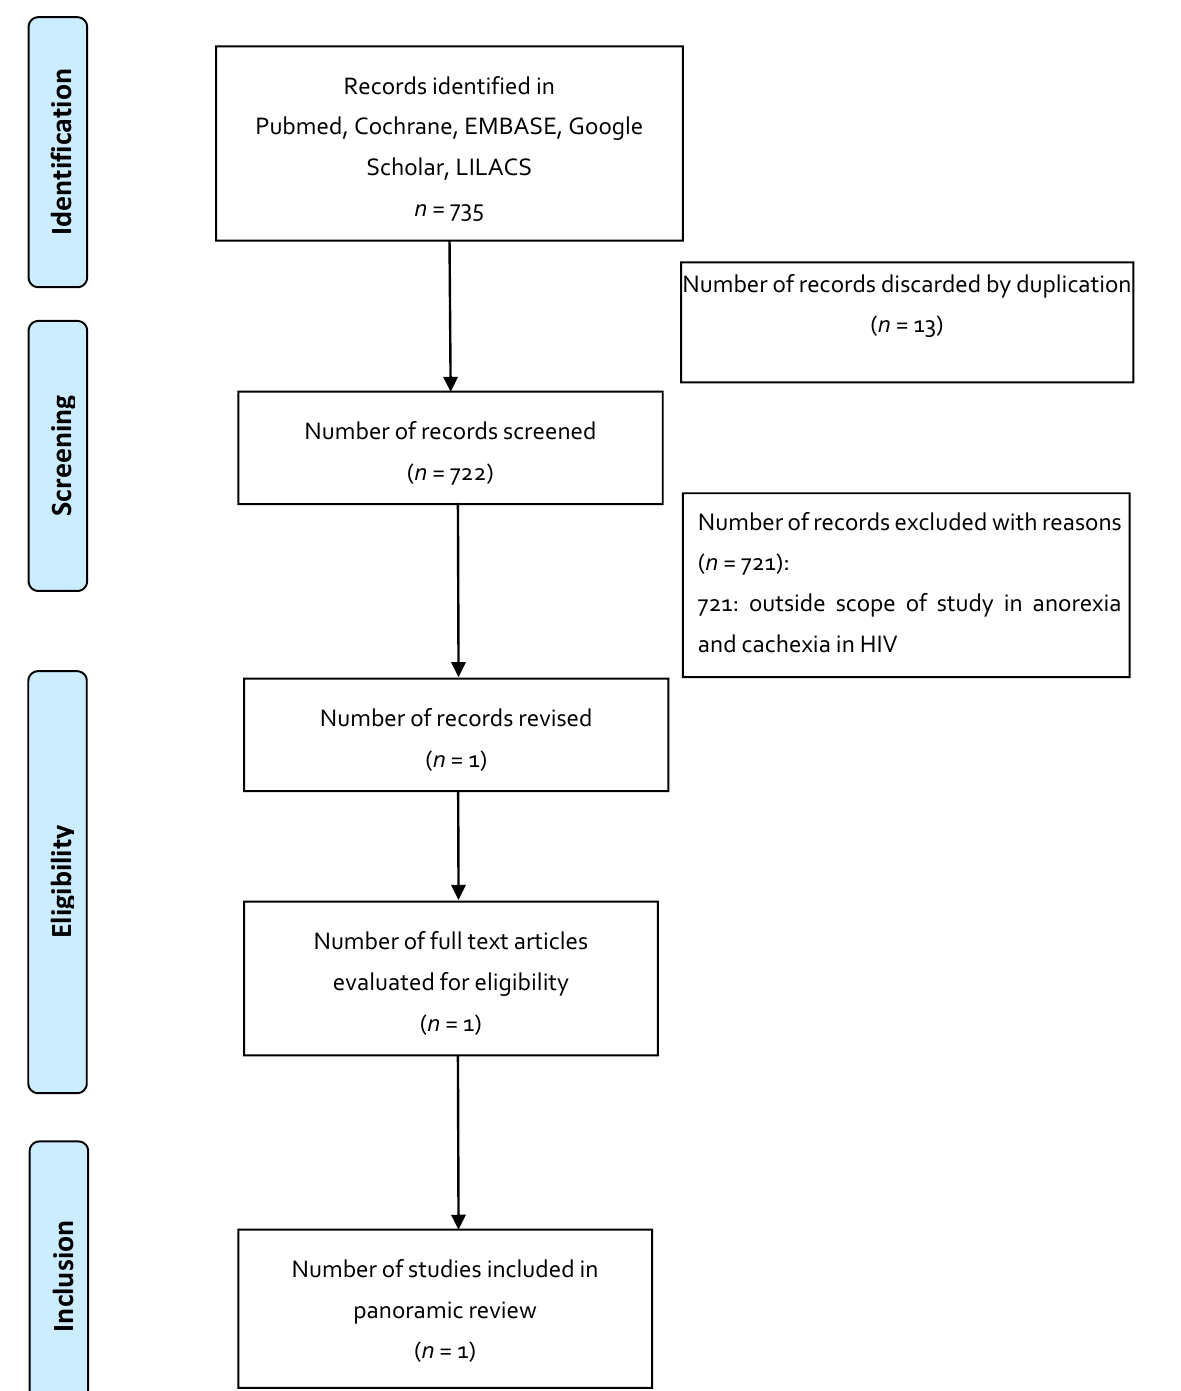
Figure 1. Flowchart depicting the selection process for the studies included in the paper: indication in anorexia and cachexia in